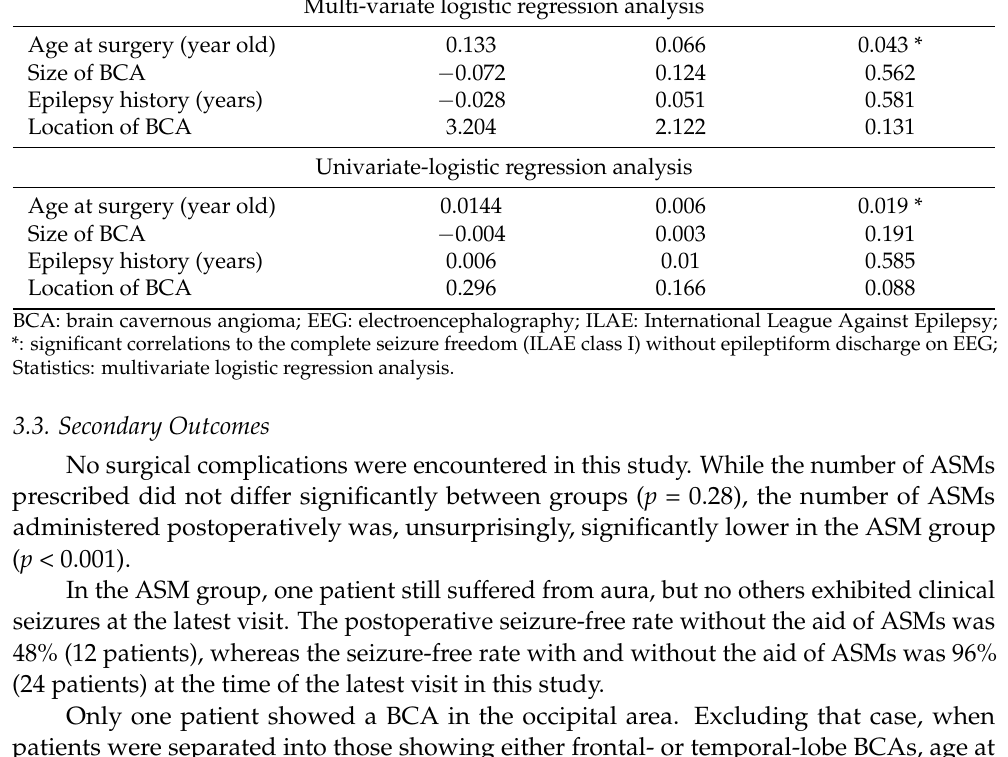
Table 2. Statistic Analyses of predictors for ILAE class I without epileptiform discharges on scalp EEG. Coefficient Standard Error p -Value Multi-variate logistic regression analysis